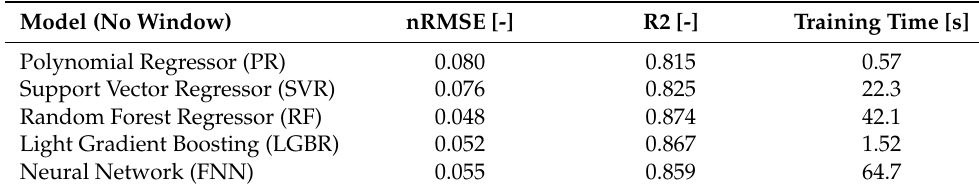
Table 4. Models Performance without Sliding Window.